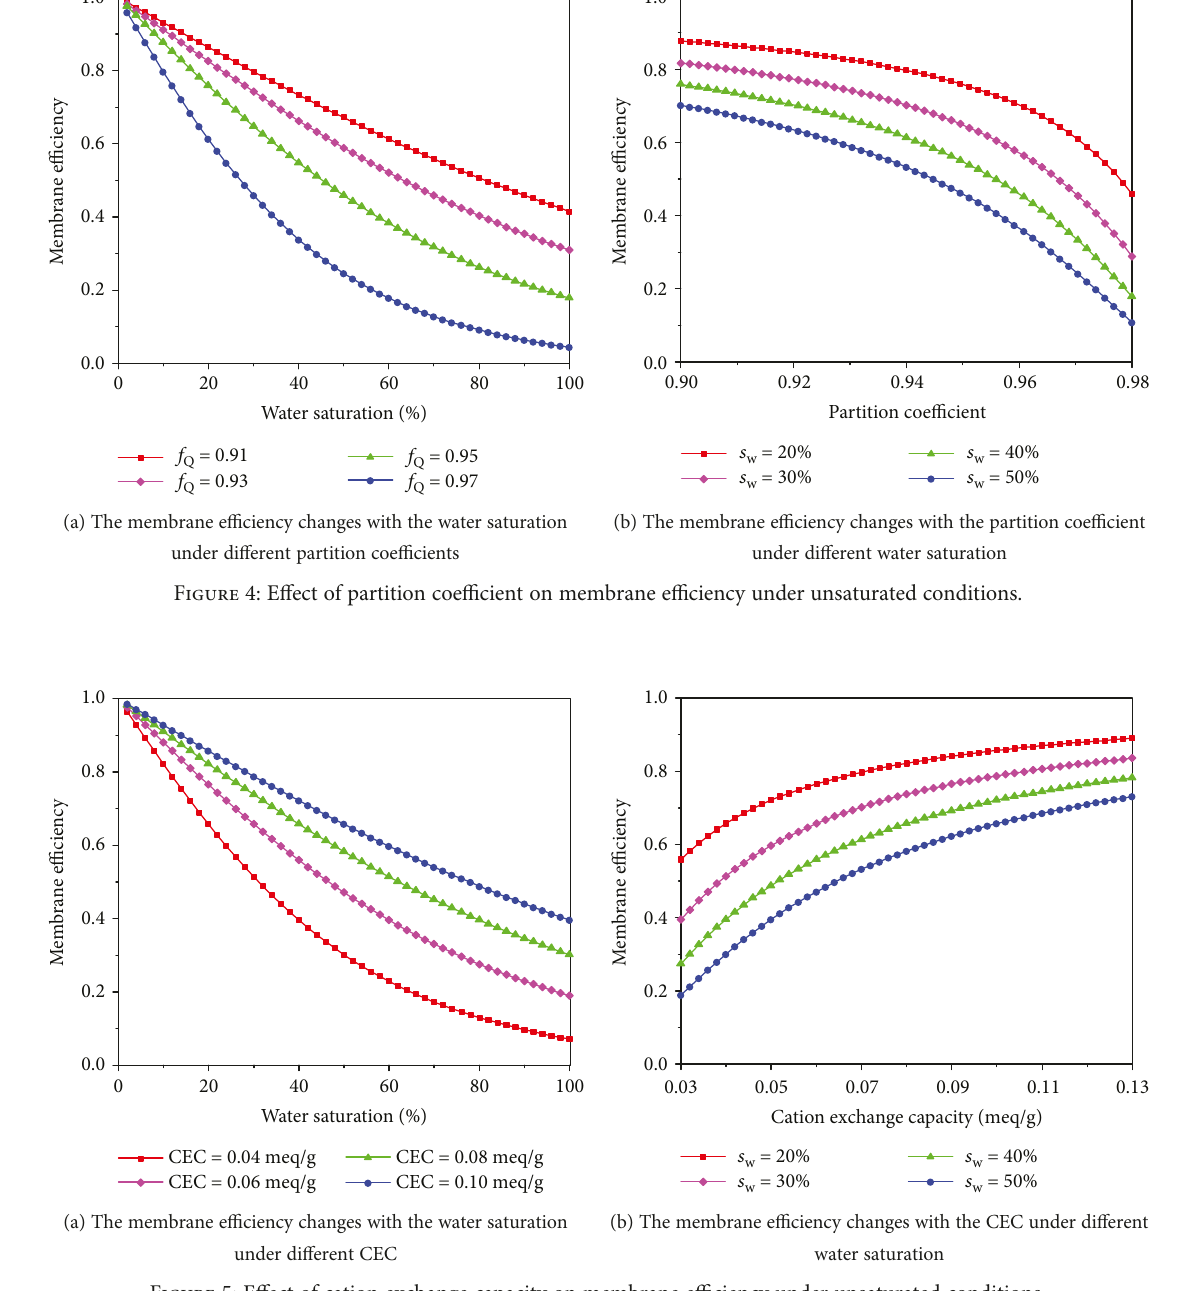
Figure 5: E ff ect of cation exchange capacity on membrane e ffi ciency under unsaturated